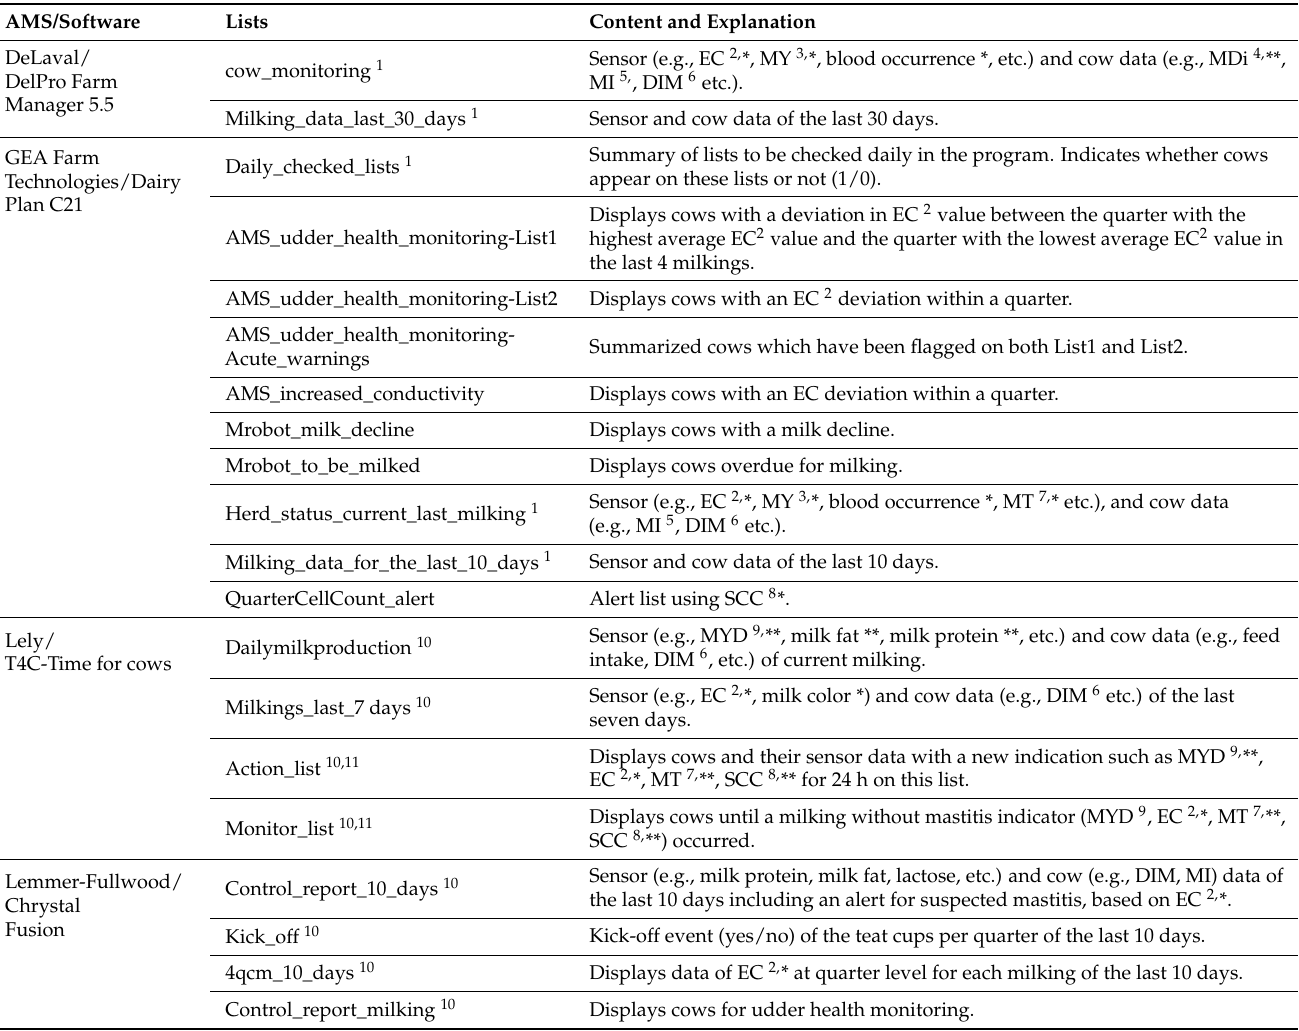
Table 1. Udder health lists of each manufacturer’s herd-management software used for this